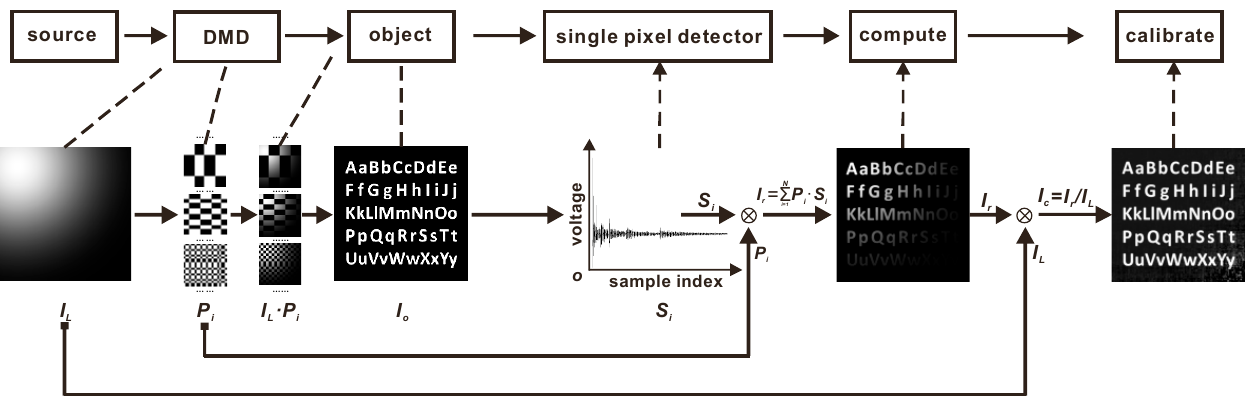
Figure 1. Numerical simulation flow chart. The light source was non-uniform, the intensity distribution of which was Gaussian. 128 × 128 Hadamard marks were used as sampling masks.